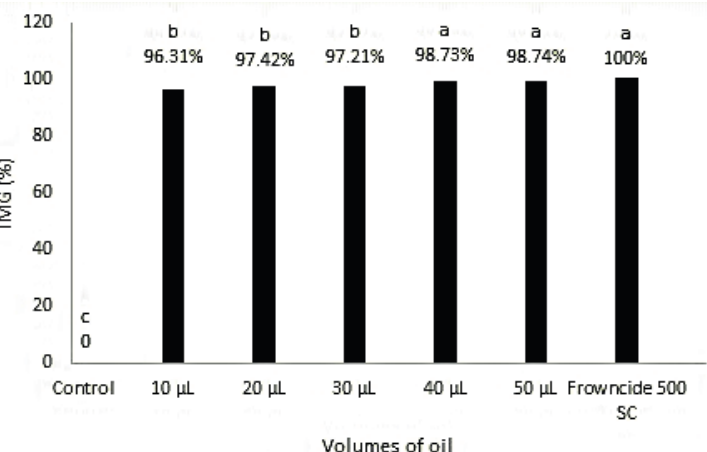
Figure 3 - Percentages of inhibition of mycelial growth of Sclerotinia sclerotiorum at different volumes of essential oils from P. aduncum leaves. Means followed by the same letter do not differ from each other by the Scott-Knott